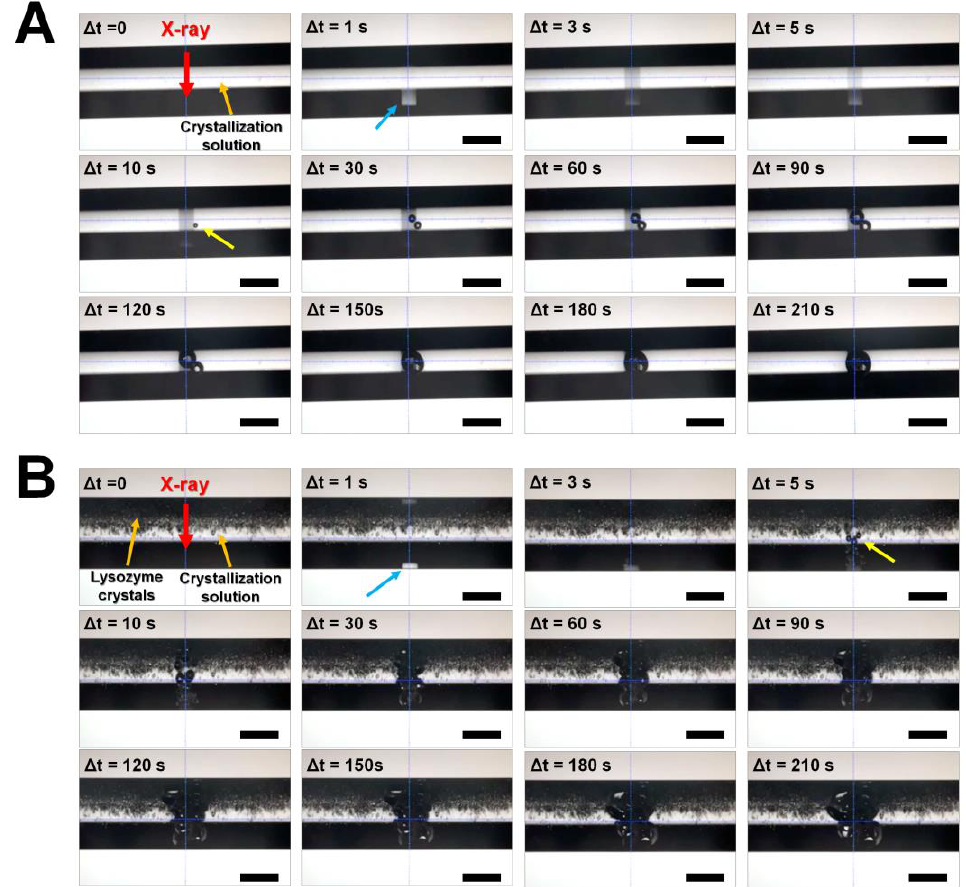
Figure 1. Observation of X-ray-induced radiation damage at the beamline 7A at PLS-II. Time-lapse view of the radiation damage of ( A ) crystal suspension and ( B ) crystallization solution. The X-ray beam path and the gas bubbles are indicated by blue and yellow arrows, respectively. Scale bar indicates 250 μm.